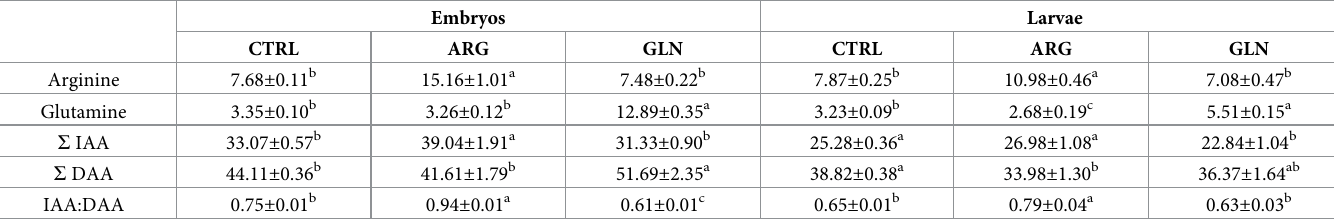
Table 1. Zebrafish embryos free amino acids profile.